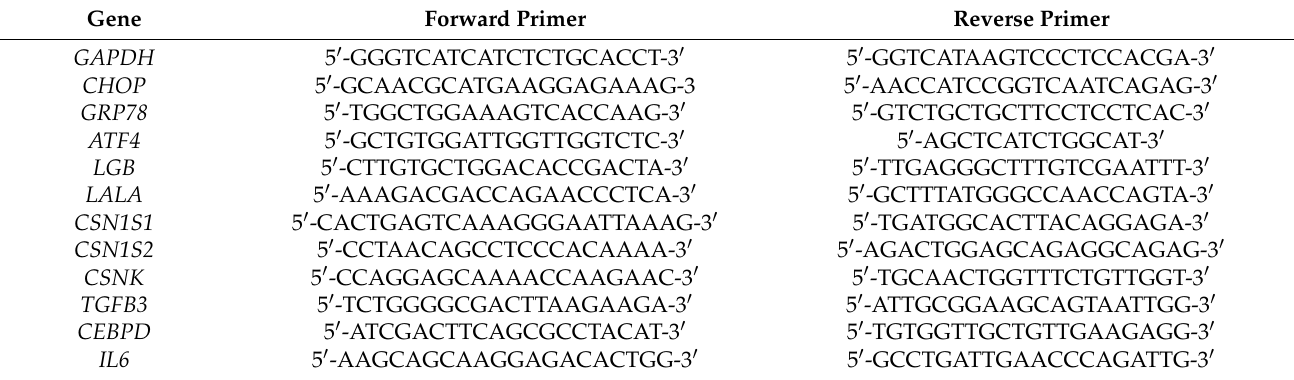
Table 1. List of primers for